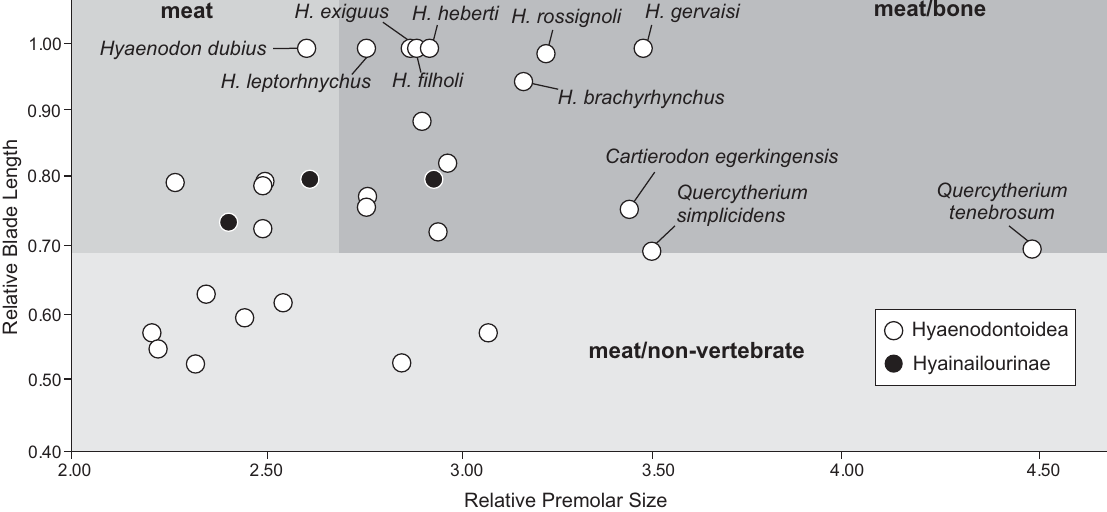
Fig. 6. Bivariate plots representing the Relative Premolar Size (RPS) versus the Relative Blade Length (RBL) for some selected hyaenodonts from the Eocene of Europe. Table 2. Estimations of the Relative Blade Length (RBL) and Relative Premolar Size (RPS) values of several hyaenodonts from